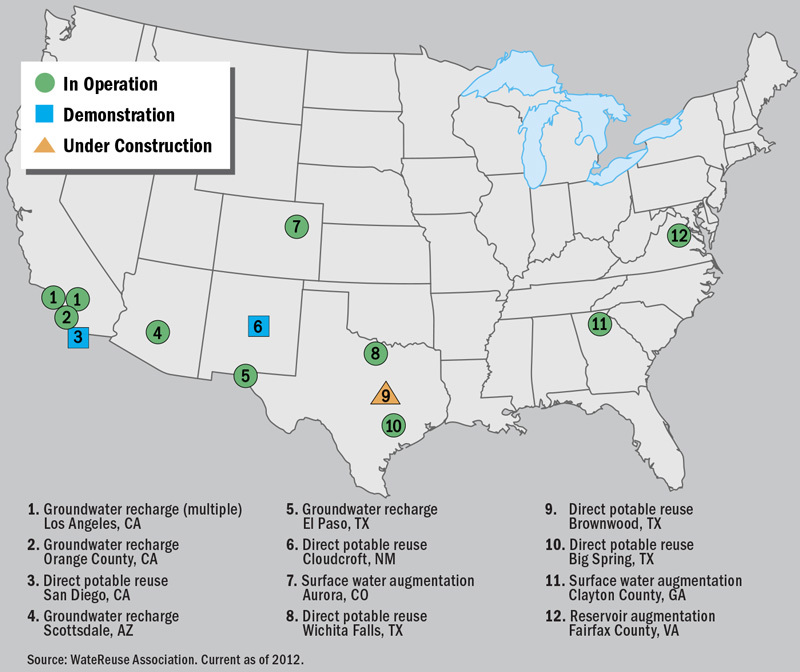
U.S. Potable Reuse Projects1. Groundwater recharge (multiple)Los Angeles, CA2. Groundwater rechargeOrange County, CA3. Direct potable reuseSan Diego, CA4. Groundwater rechargeScottsdale, AZ5. Groundwater rechargeEl Paso, TX6. Direct potable reuseCloudcroft, NM7. Surface water augmentationAurora, CO8. Direct potable reuseWichita Falls, TX9. Direct potable reuseBrownwood, TX10. Direct potable reuseBig Spring, TX11. Surface water augmentationClayton County, GA12. Reservoir augmentationFairfax County, VASource: WateReuse Association. Current as of 2012.